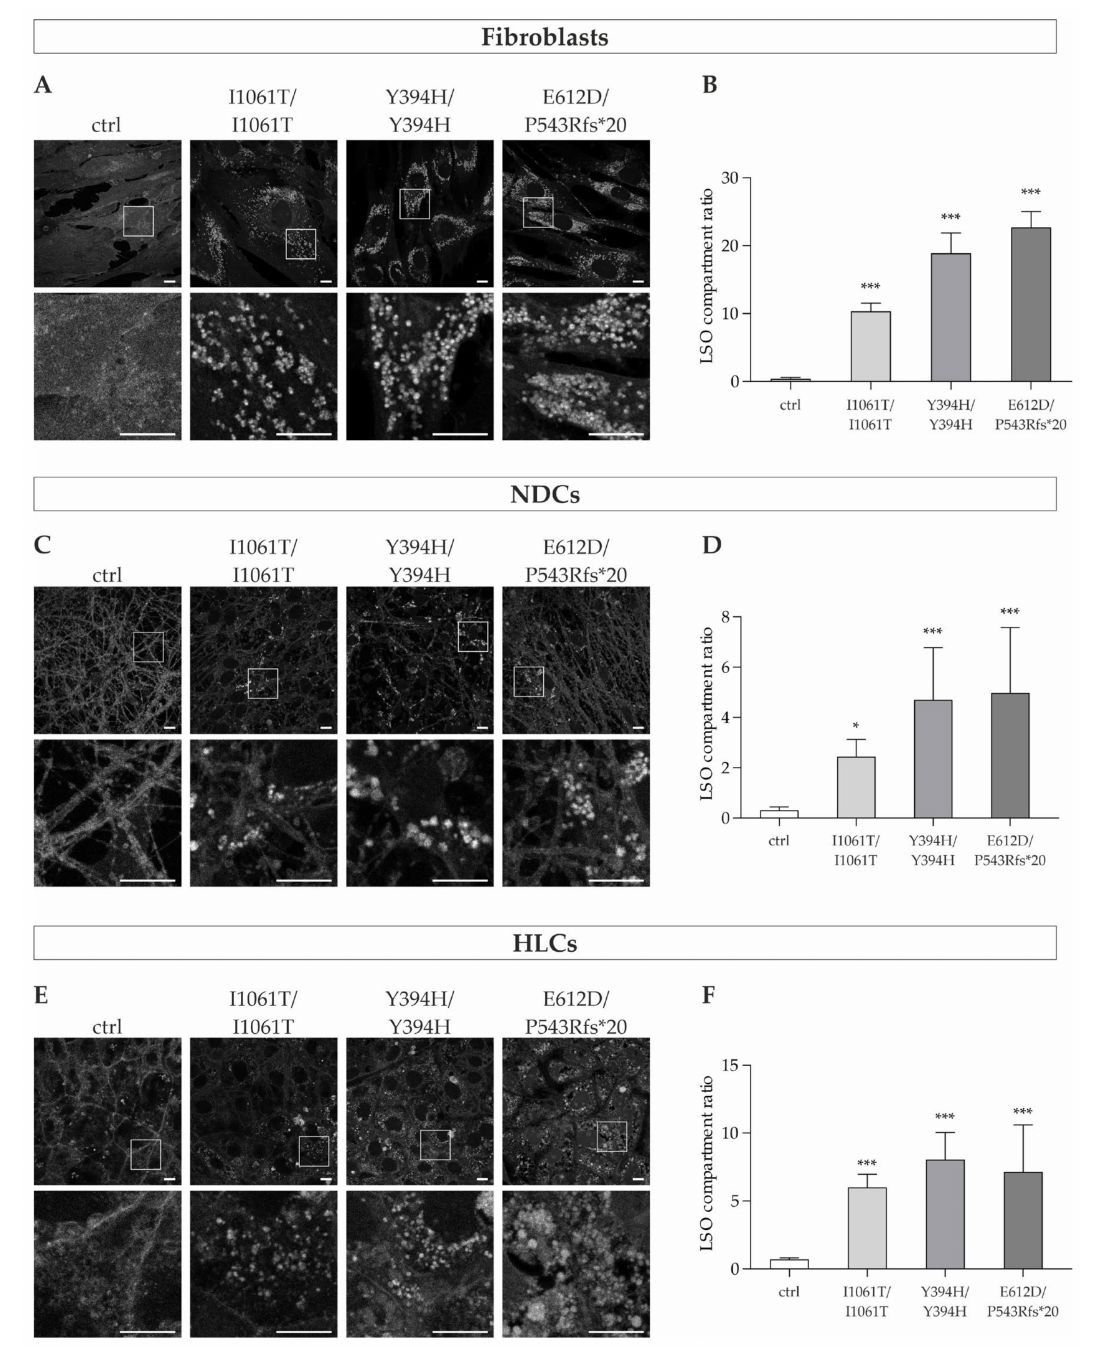
Figure 2. Cholesterol levels in NP-C1 patients’ fibroblasts, neural differentiated and hepatocyte- like cells. ( A , C , E ) Representative images of filipin-stained fibroblasts, neural differentiated cells and hepatocyte-like cells, respectively. Magnified images of the squared region of each image are shown below each one. In NPC1-deficient cell lines, bright fluorescent puncta are present, indicative of cholesterol accumulations in the lysosomes of the cells. In contrast, the control cells showed a weak overall fluorescence intensity with no fluorescent vesicles present. Scale bar = 10 µ m. ( B , D , F ) Quantification of the lysosome-like storage organelles compartment ratio (LSO compartment ratio), which relates the cholesterol accumulation seen as fluorescent puncta to the total area of the cells. The LSO compartment ratio was significantly increased in fibroblasts, neural differentiated cells, and hepatocyte-like cells of NP-C1 patients compared to the control cell line, demonstrating an abnormal, increased amount of cholesterol in the cells. N = 8. * = p < 0.05, *** = p < 0.001 by one-way ANOVA followed by the Dunnett’s post hoc test compared to ctrl. NDCs = neural differentiated cells; HLCs = hepatocyte-like